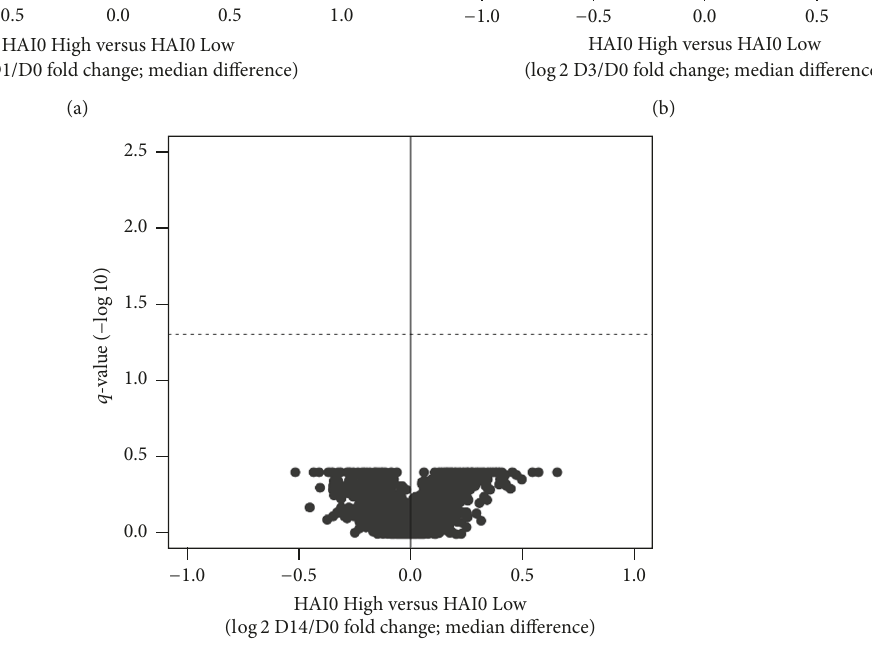
to apply SCUDO to this dataset for confirmatory